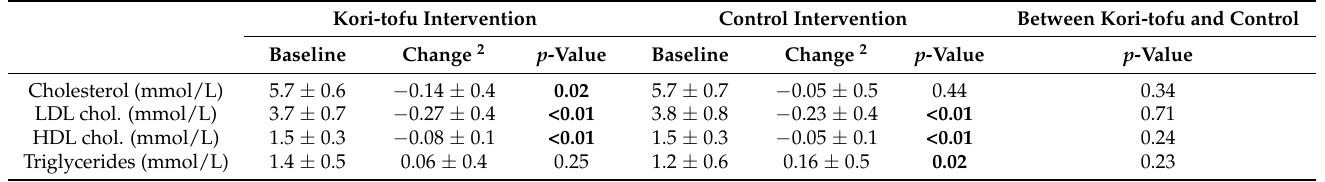
Table 2. Baseline values and changes in total cholesterol, low-density lipids (LDL) cholesterol, high-density lipids (HDL) cholesterol and triglyceride levels after 4 weeks Kori-tofu or control intervention 1 . Kori-tofu Intervention Control Intervention Between Kori-tofu and Control Baseline Change 2 p -Value Baseline Change 2 p -Value p -Value Cholesterol